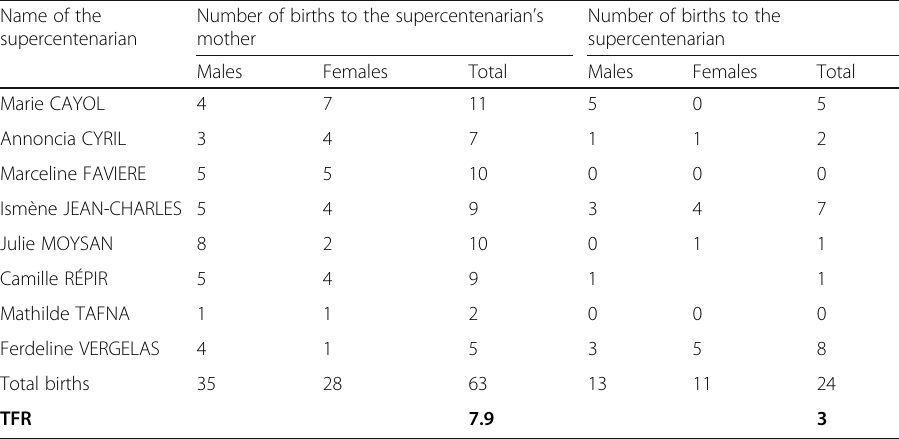
Table 4 Children ever born from mothers of Guadeloupean supercentenarians and from supercentenarians